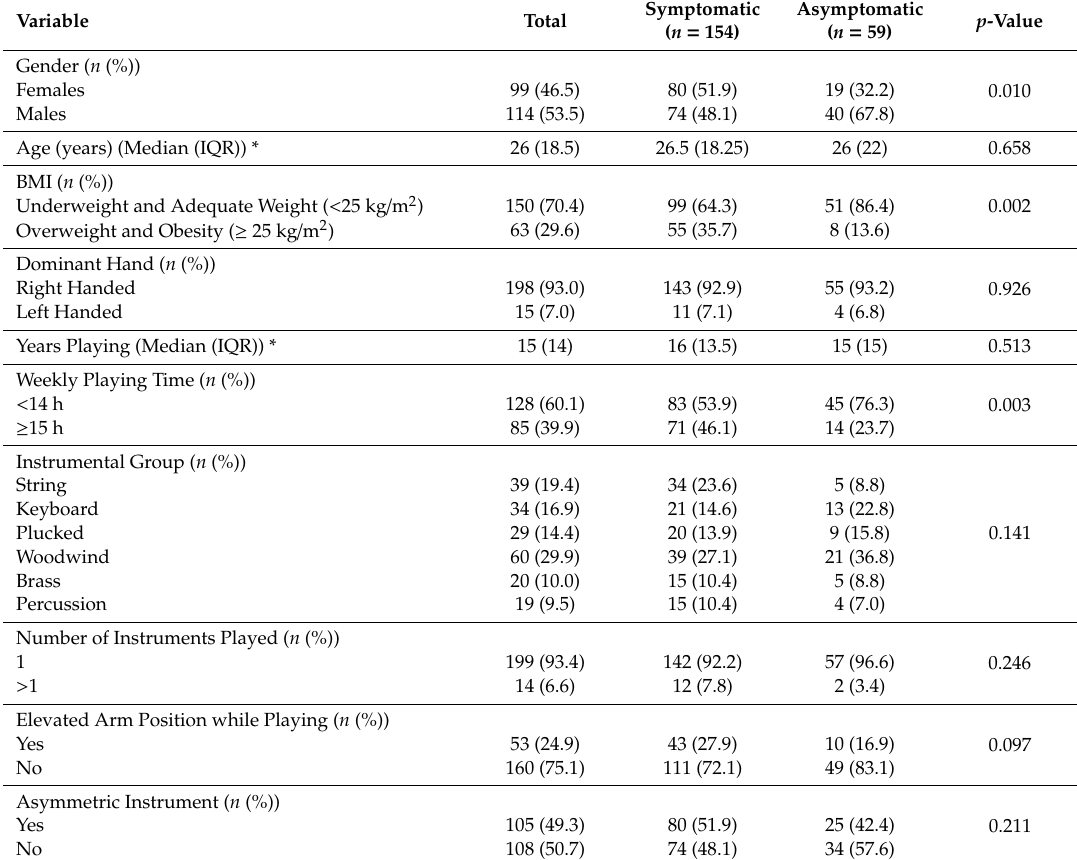
Table 2. Sociodemographic and instrumental practice data compared by symptomatology in the last seven days ( n =